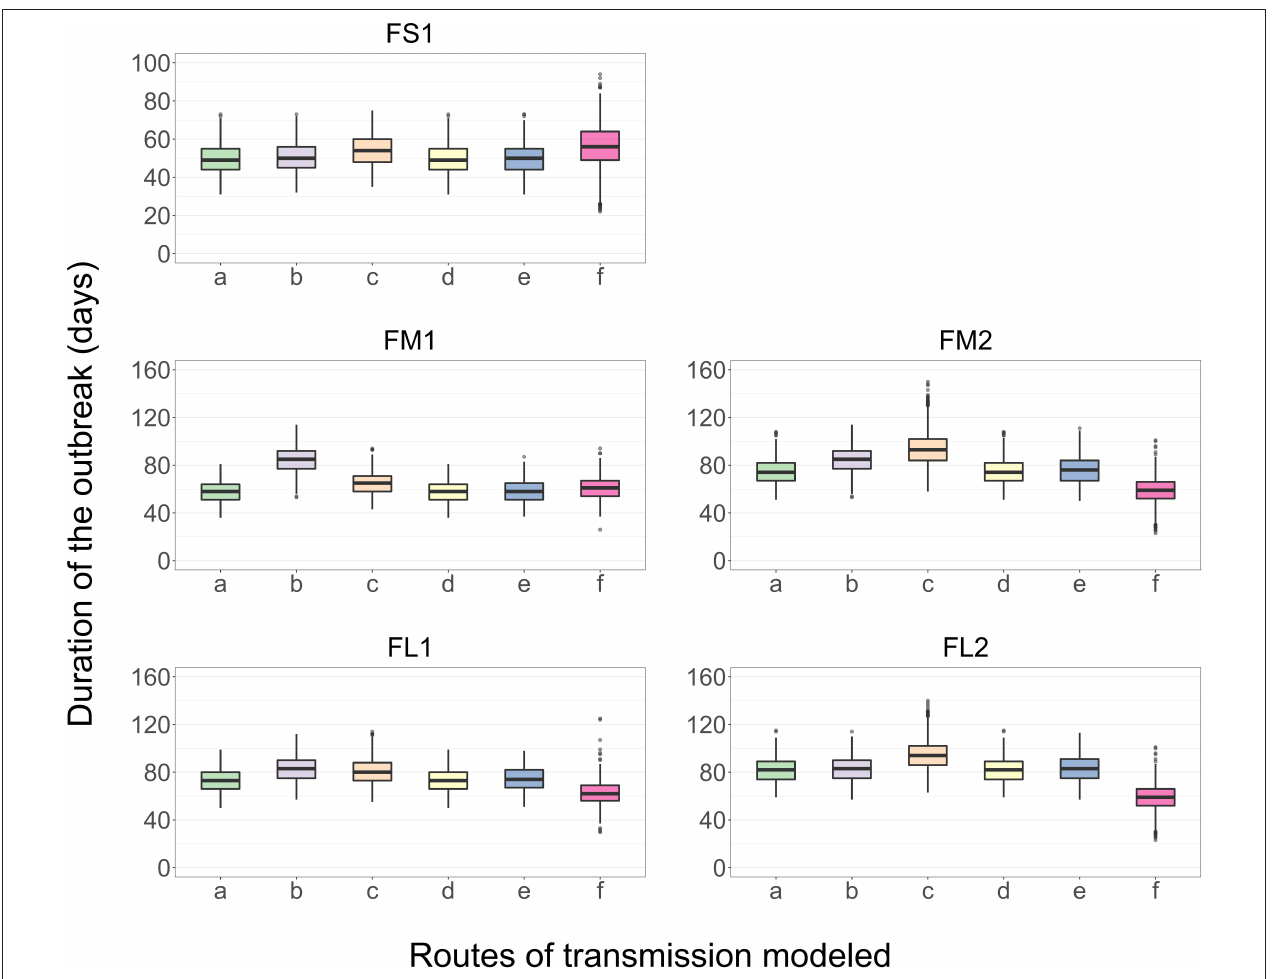
FIGURE 6 | Boxplot of the projected duration of a foot-and-mouth disease outbreak on a U.S. beef cattle feedlot for n = 2,000 simulated outbreaks in the feedlot of that size and layout sampling the values of the target parameters, when the full model incorporating all the routes of FMD virus transmission among the home-pens or a model with one of the transmission routes excluded was simulated. a—all the routes of FMD virus transmission among home-pens incorporated, b—transmission via direct contact of cattle in the hospital-pens excluded; c—fence-line transmission between cattle in neighboring home-pens excluded; d—transmission of virus contaminated material between home-pens by the pen-riders excluded; e—transmission via contaminated water-troughs excluded; and f—airborne transmission excluded. Feedlot size and layout cases modeled: FS1 is a 4,000 cattle feedlot with one hospital-pen; FM1 is a 12,000 cattle feedlot with one hospital-pen; FM2 is a 12,000 cattle feedlot with two hospital-pens; FL1 is a 24,000 feedlot with two hospital-pens; and FL2 is a 24,000 cattle feedlot with four hospital-pens (in all the layouts n = 200 cattle per